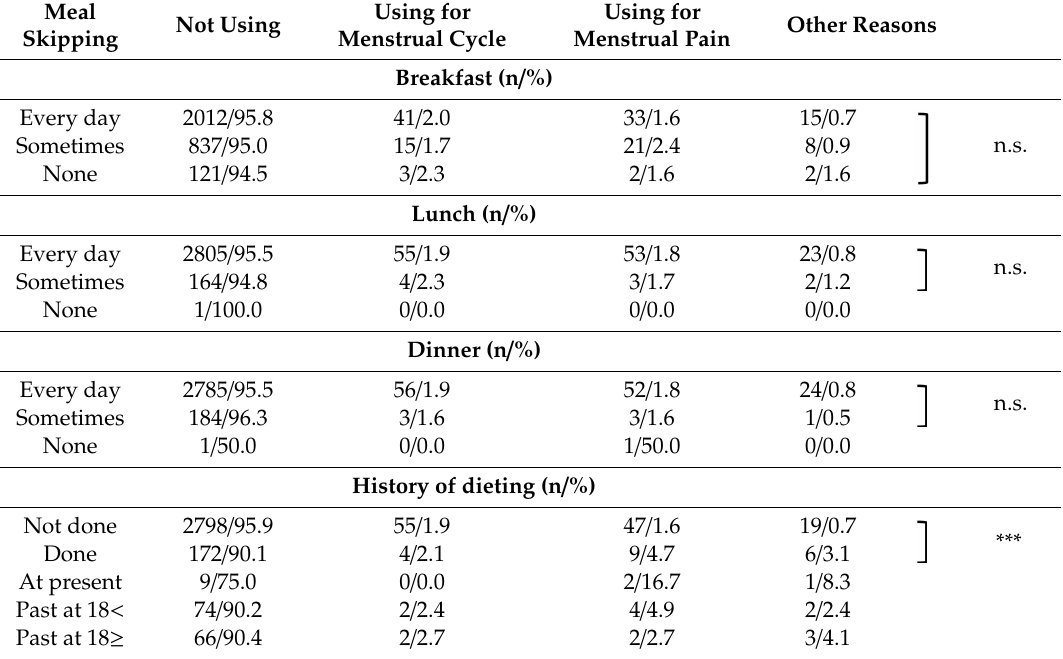
Table 5. Relationship between use of contraceptives and meal skipping or dietary